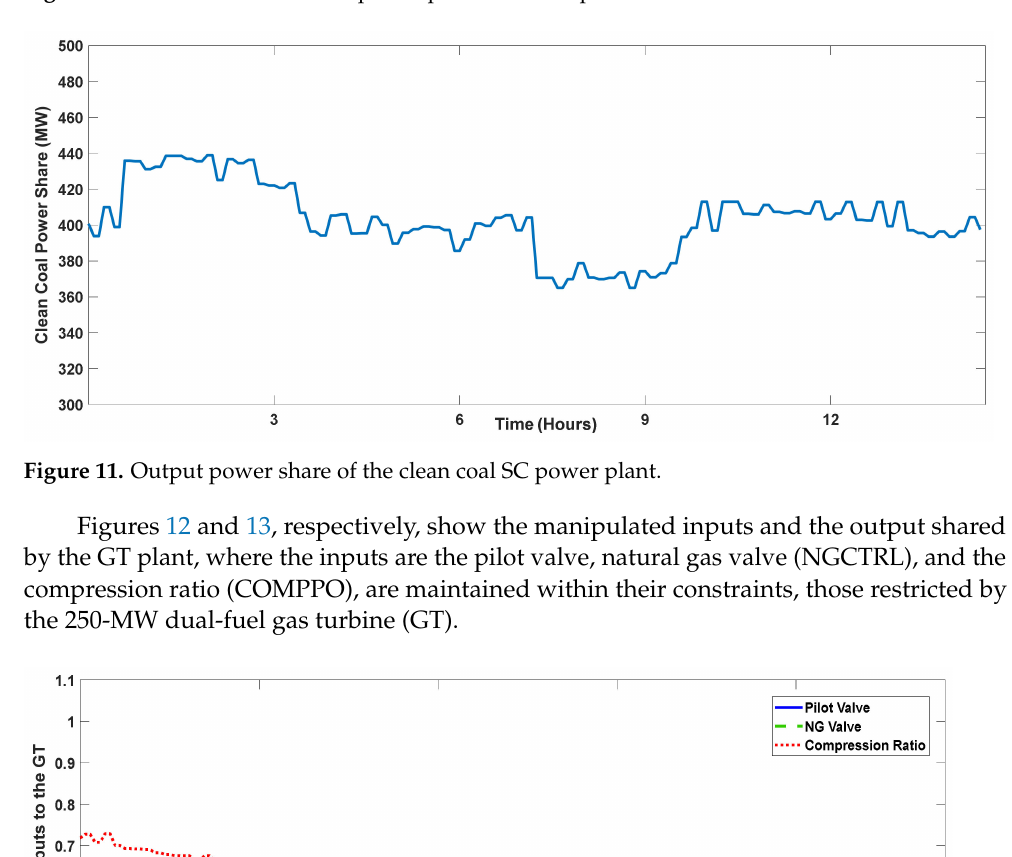
Figure 10. Normalized clean coal power plant control inputs to the SCPP.